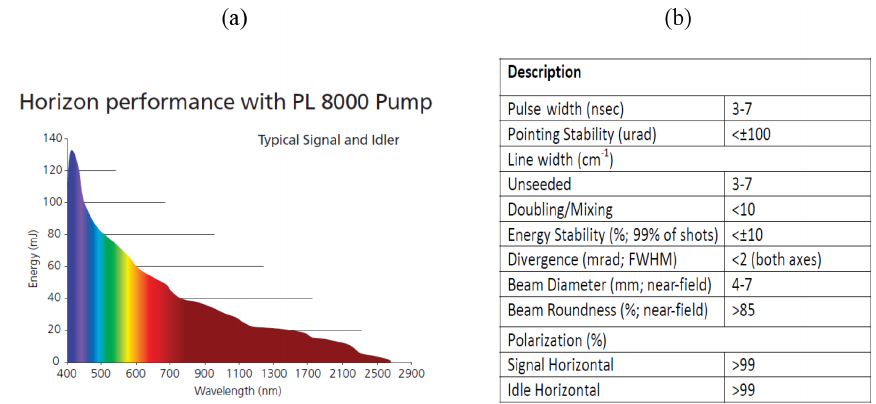
Figure 3. Continuum Horizon II energy outputs (a) and parameters (b) with PL 8000 pump.